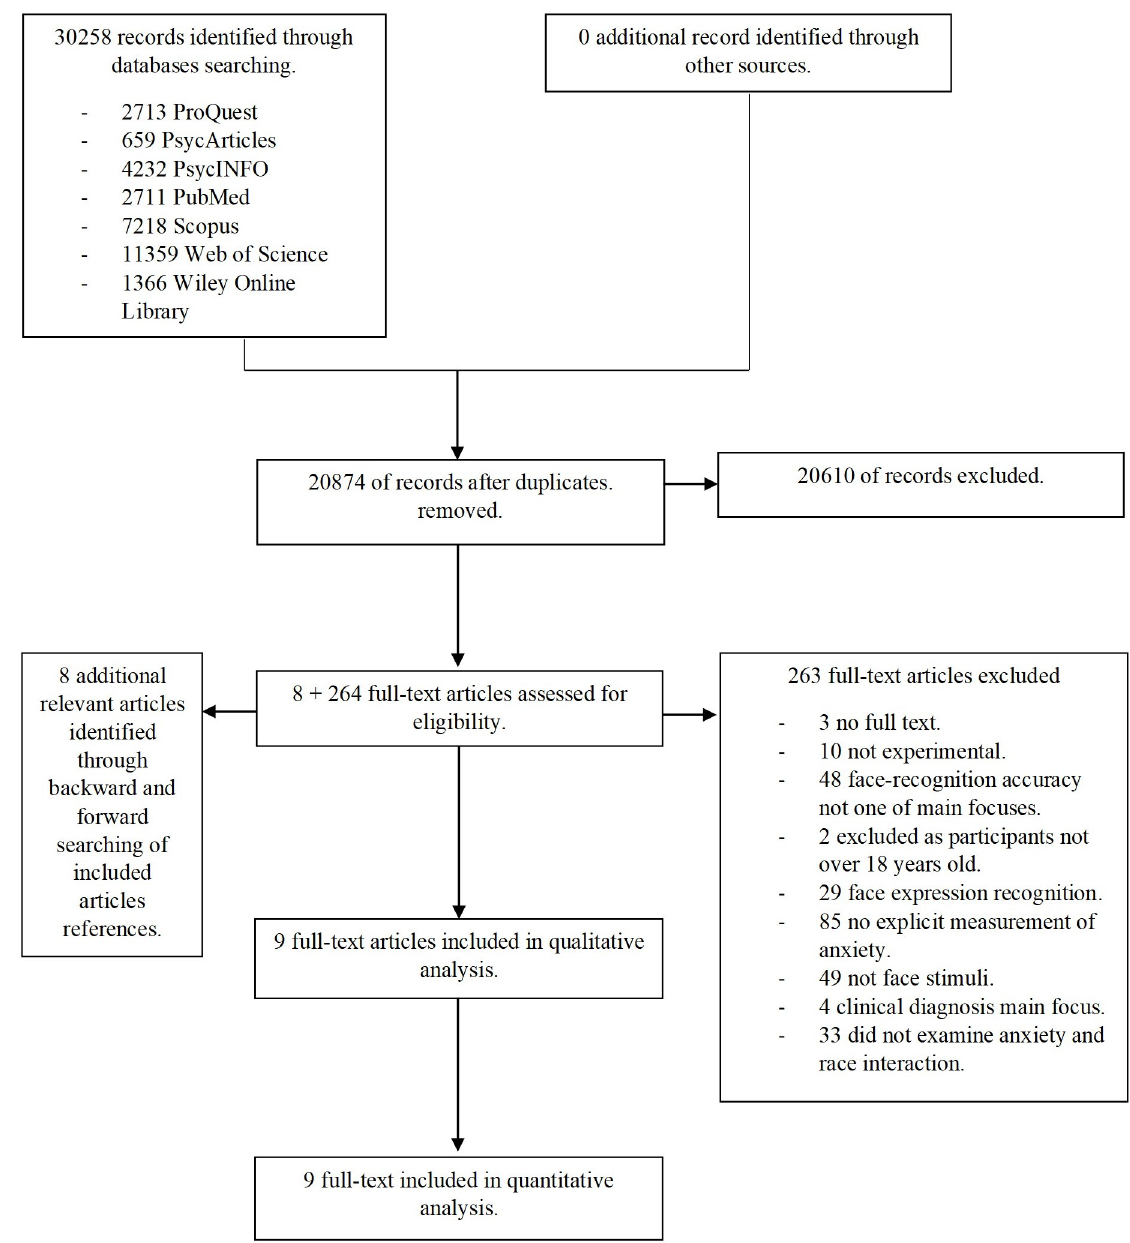
Fig 1. Flowchart of the results for the literature